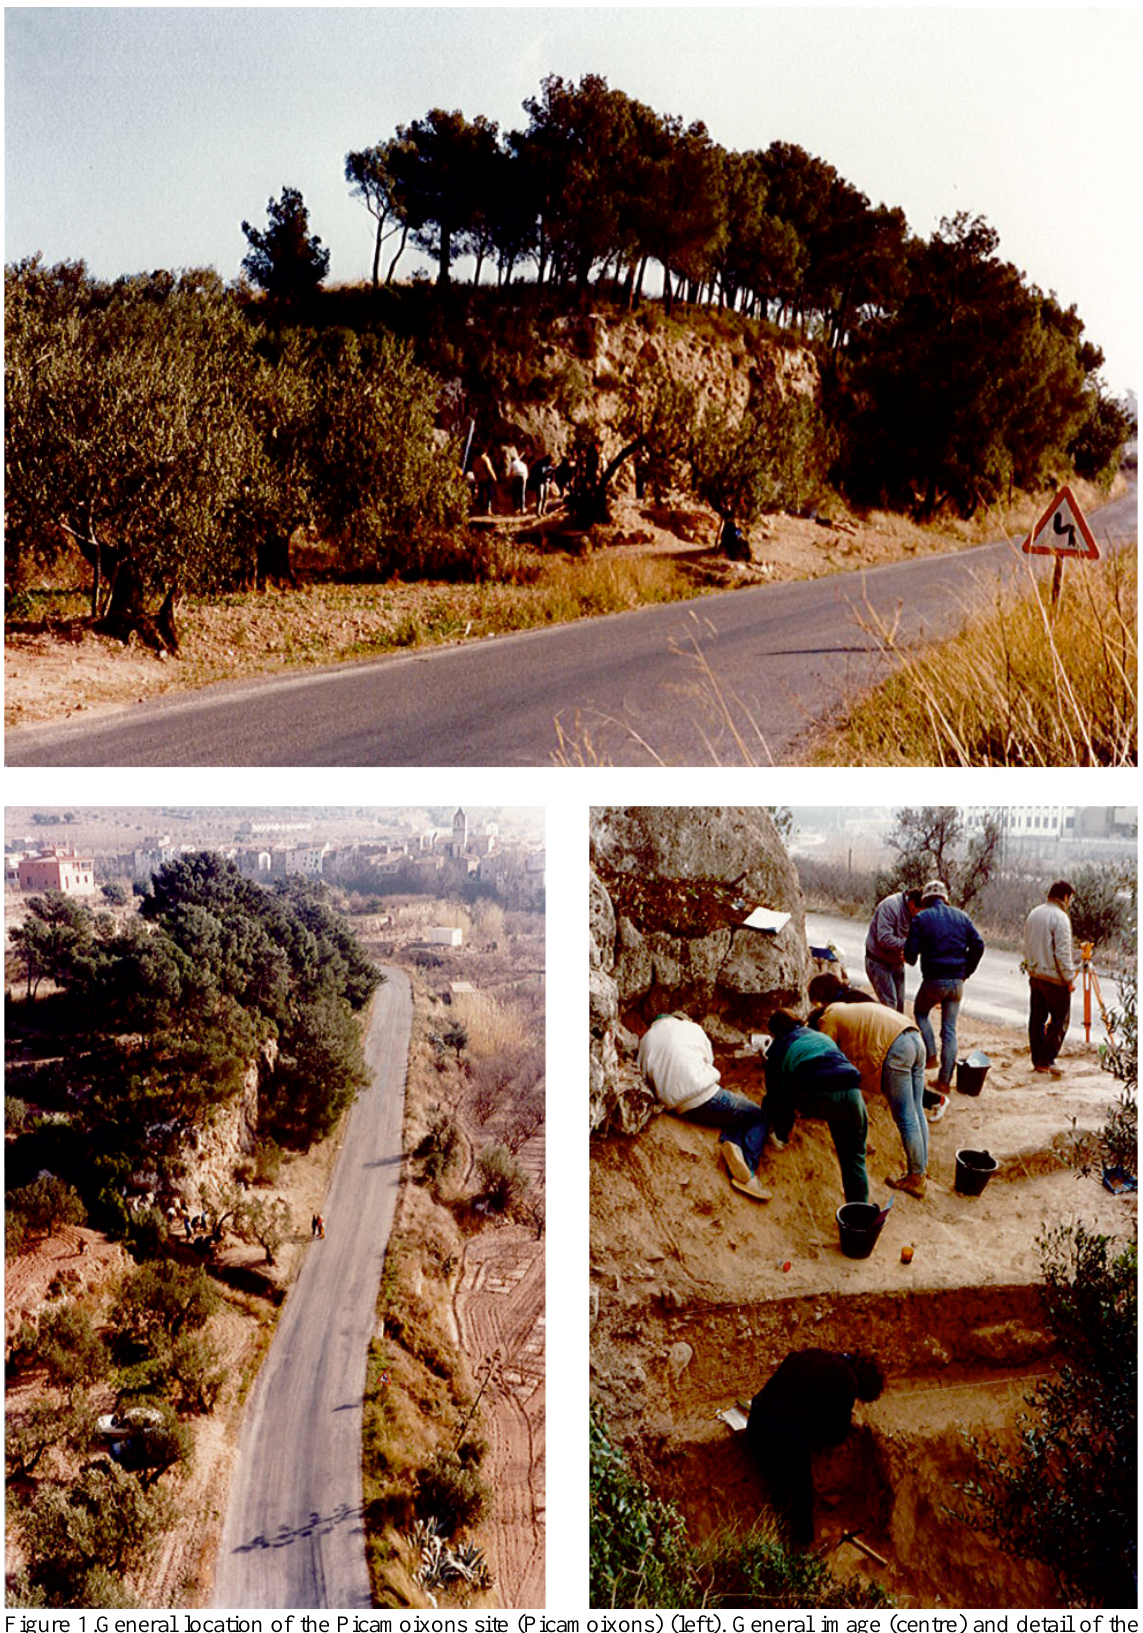
Figure 1.General location of the Picamoixons site (Picamoixons) (left). General image (centre) and detail of the fieldwork (right) carried out in 1988 (J.M.